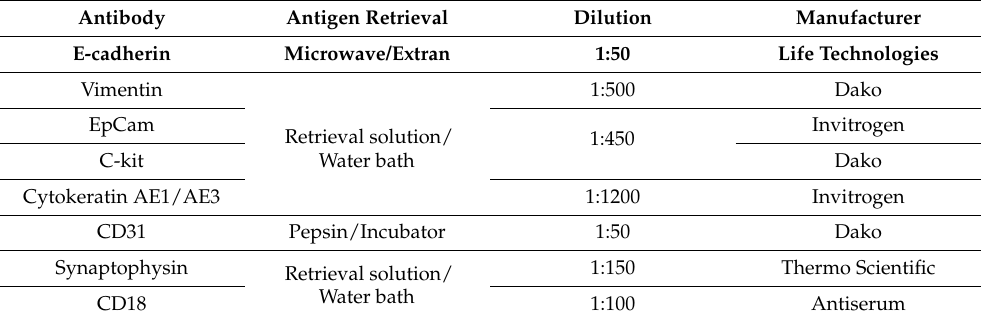
Table 1. Antibodies used and conditions applied in the immunocytochemical analysis. Antibody Antigen Retrieval Dilution Manufacturer E-cadherin Microwave/Extran 1:50 Life